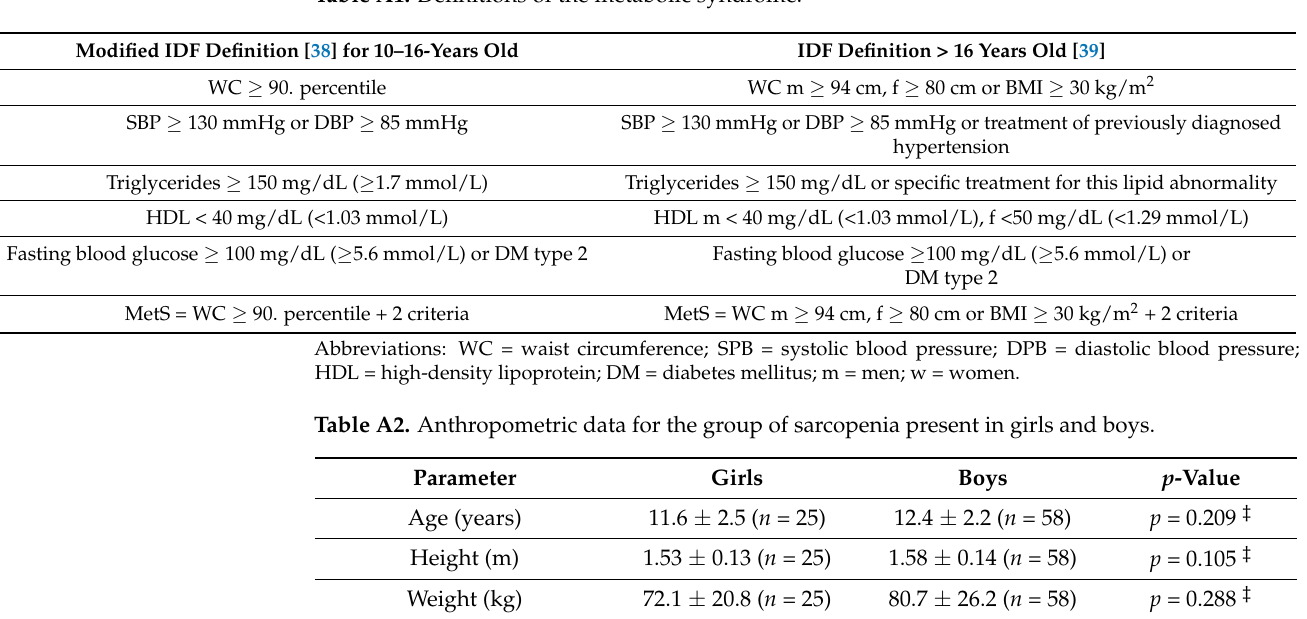
Table A1. Definitions of the metabolic syndrome.